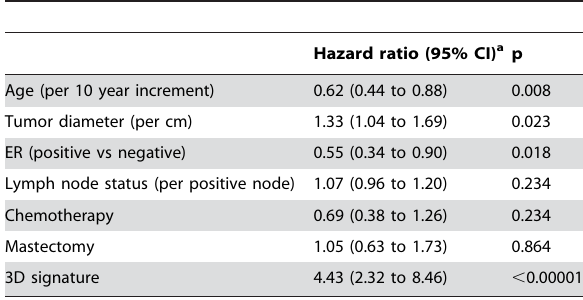
Table 4. Multivariable proportional-hazards analysis of 10 year survival